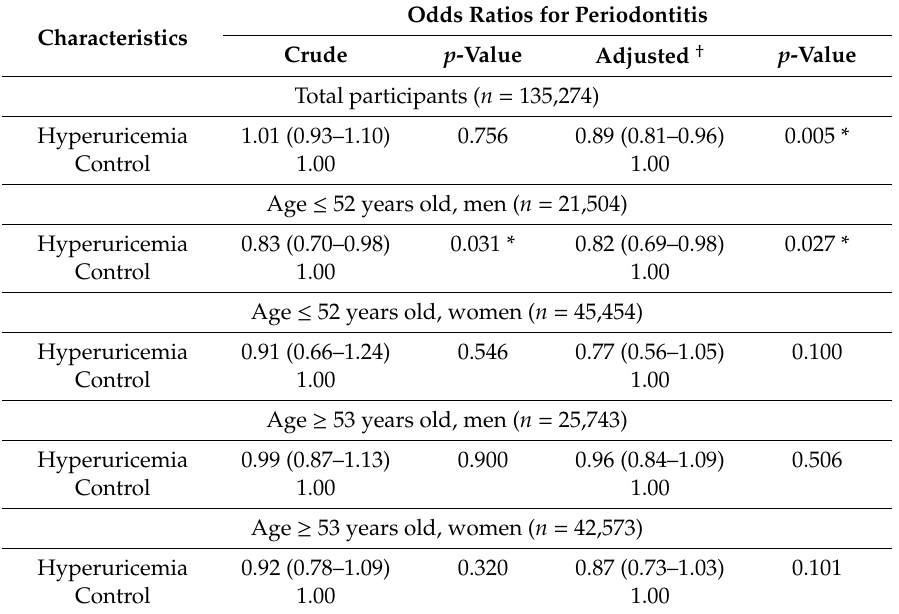
Table 2. Crude and adjusted odds ratios (95% confidence interval) for periodontitis in hyperuricemia and control participants.